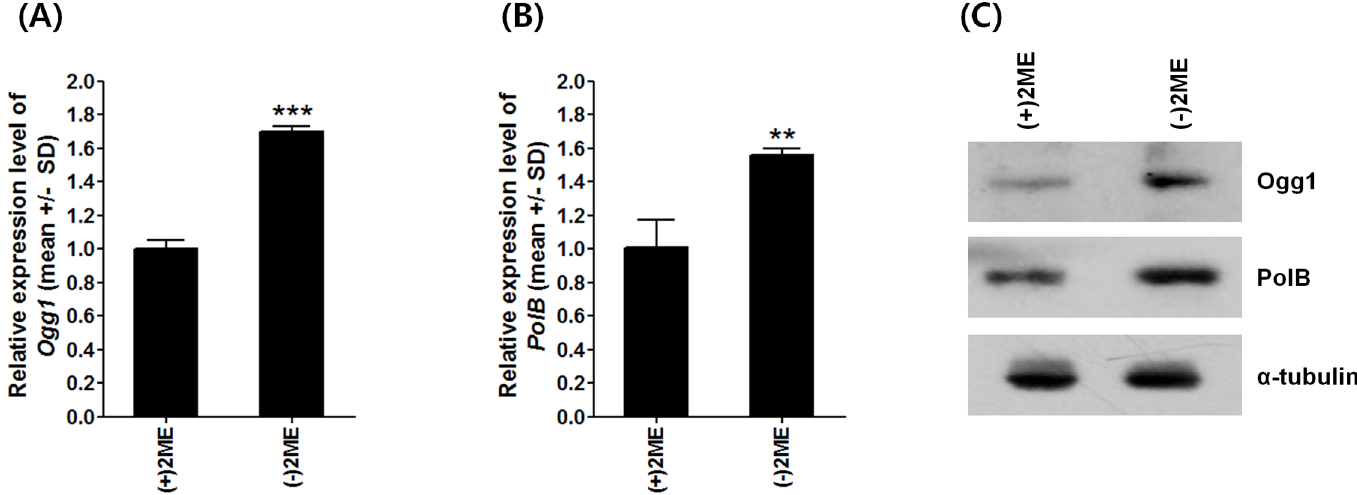
Fig 4. Differential expression levels of 8-oxoG repair genes Ogg1 and PolB in ESCs induced by oxidative stress. Relative mRNA levels of (A) Ogg1 mRNA and (B) PolB . Gapdh was used as an internal control. Mean ± SD, ** p < 0.01, *** p < 0.001, one-sided t-test. (C) Levels of Ogg1 and PolB proteins by Western blotting. α -tubulin was used as an internal